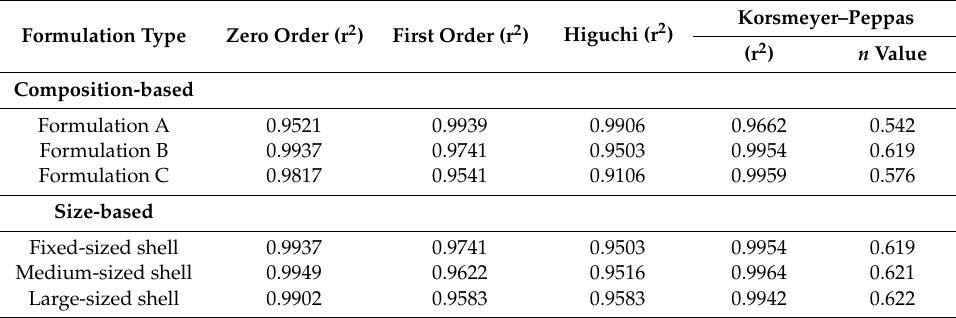
Table 5. In vitro release kinetics of propranolol HCl from 3D printed controlled-release shells of variable composition and size fitted to the best-fit release kinetic model.